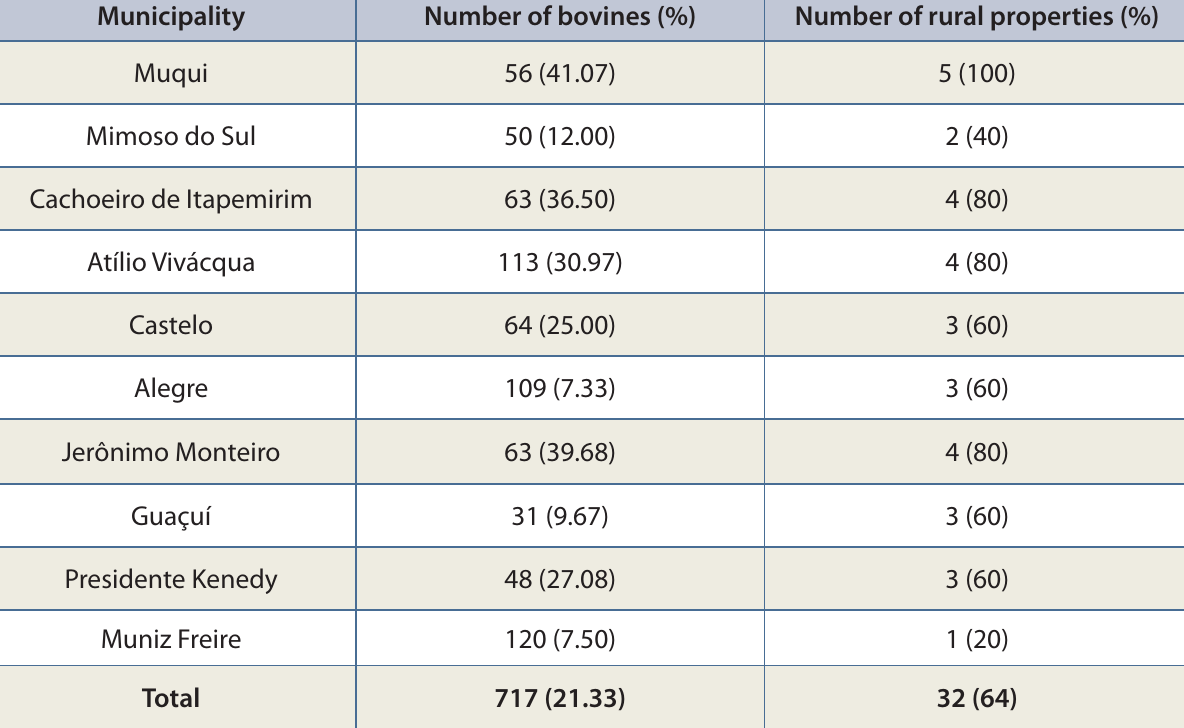
Table 1. Number of affected bovines and rural properties where Fasciola hepatica was found by coproparasitologic test in southern Espírito Santo state